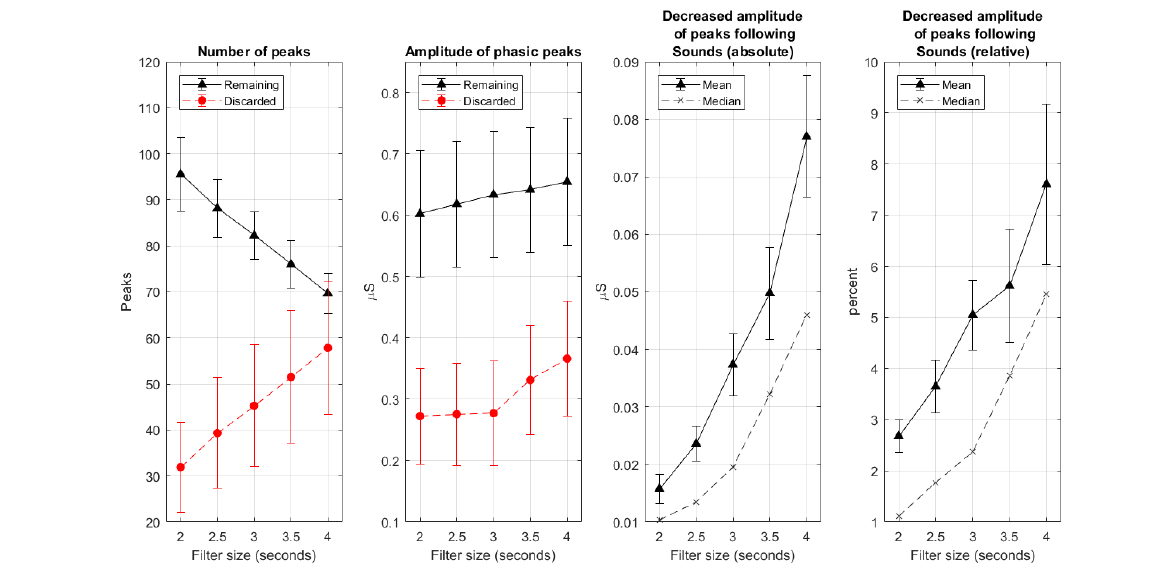
Figure 6. Effect of varying filter size from 2 to 4 s in steps of 0.5 s on the number and amplitude of phasic (remaining and discarded) peaks and on the attenuation of the amplitude of the peaks following emotional sounds (absolute values and relative values to the original peak heights in percent. Error bar √ N where N = 12 participants.). represents SD/